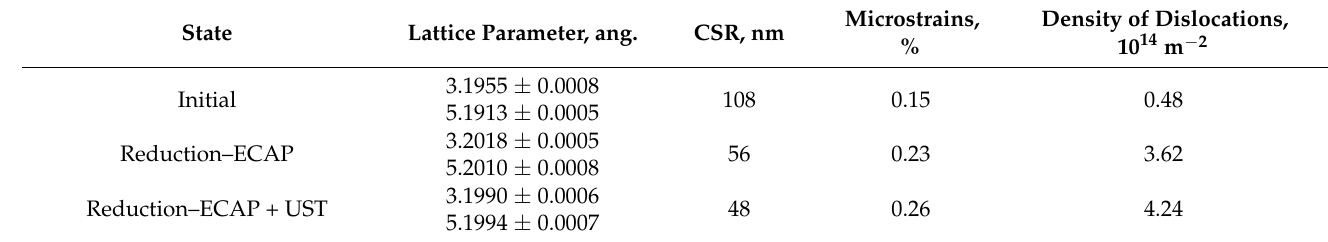
Table 2. Changes in the volumetric share (%) of second phases during reduction–ECAP and Table 1. XRD results.